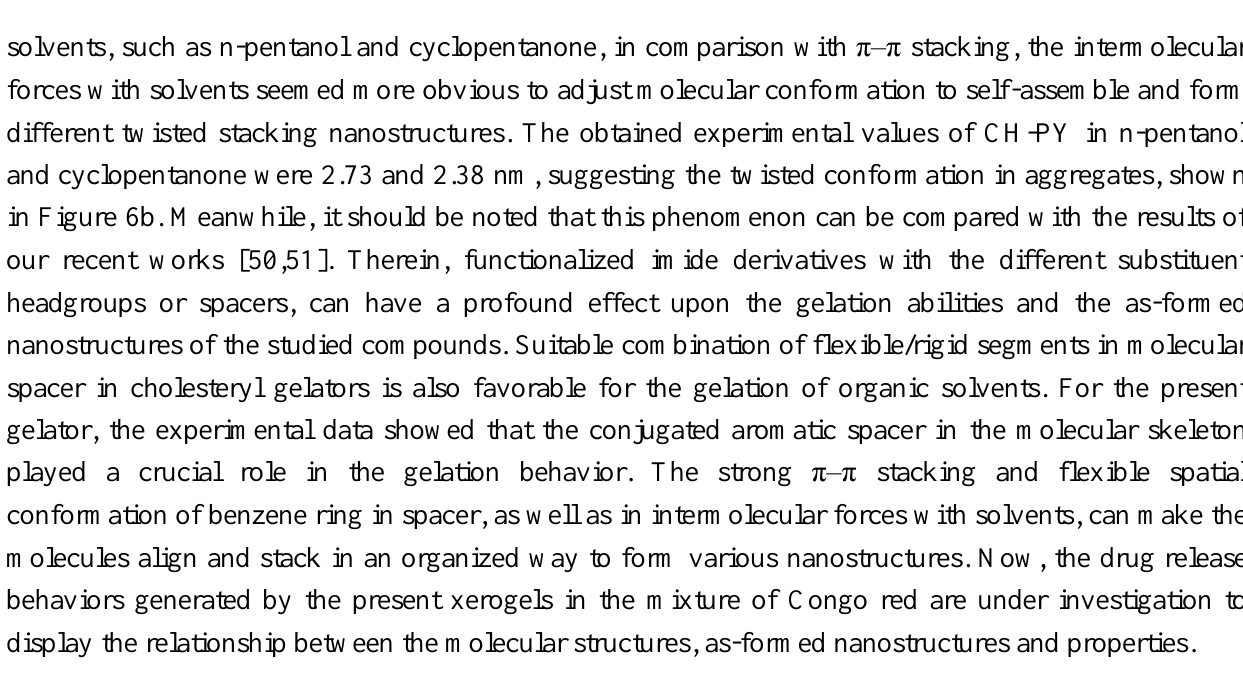
Figure 6. Rational assembly modes of CH-PY organogels in stretched stacking ( a ) 3.5 nm and twisted stacking; ( b) 2.73 and 2.38 nm,